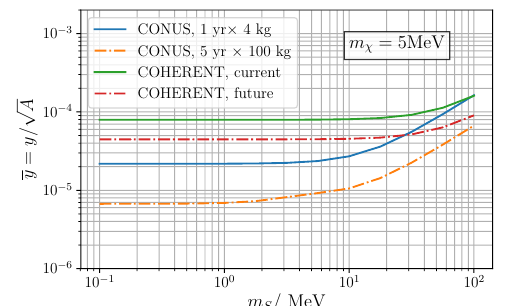
Figure 5 . Future sensitivities of CONUS (5 yr 100 kg exposure, 0.1 keV threshold) and CO- (cid:2) HERENT (statistics 100) on the benchmark m (cid:31) = 5 MeV. For more details about the future (cid:2) con(cid:12)gurations, see the